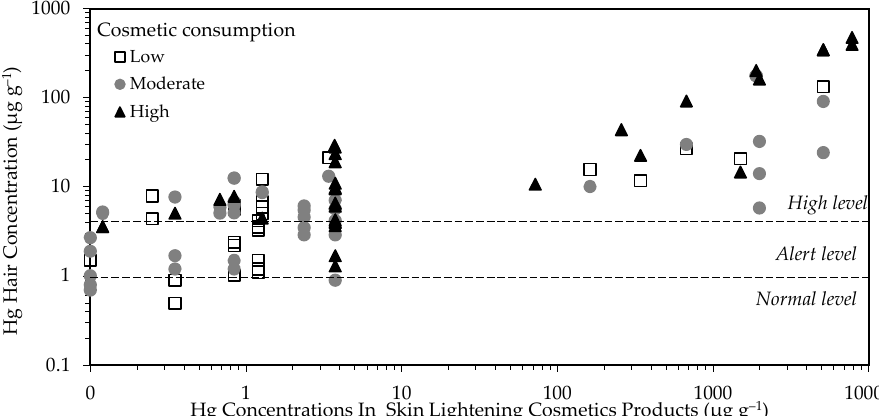
Figure 3. Correlation between Hg in hair and cosmetics in the students’ scalp hair and cosmetics for every group of cosmetic consumptions.